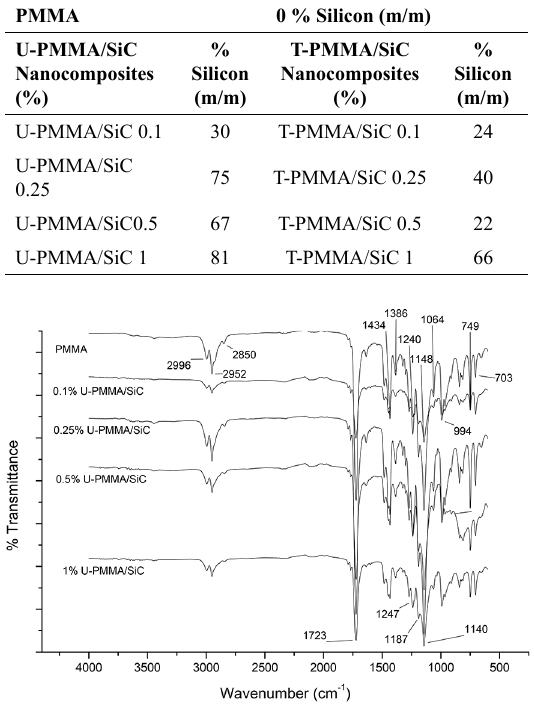
Figure 2. FTIR spectra of the neat PMMA polymer and nanocomposite samples, 0.1, 0.25, 0.5 and 1% of untreated SiC fillers.